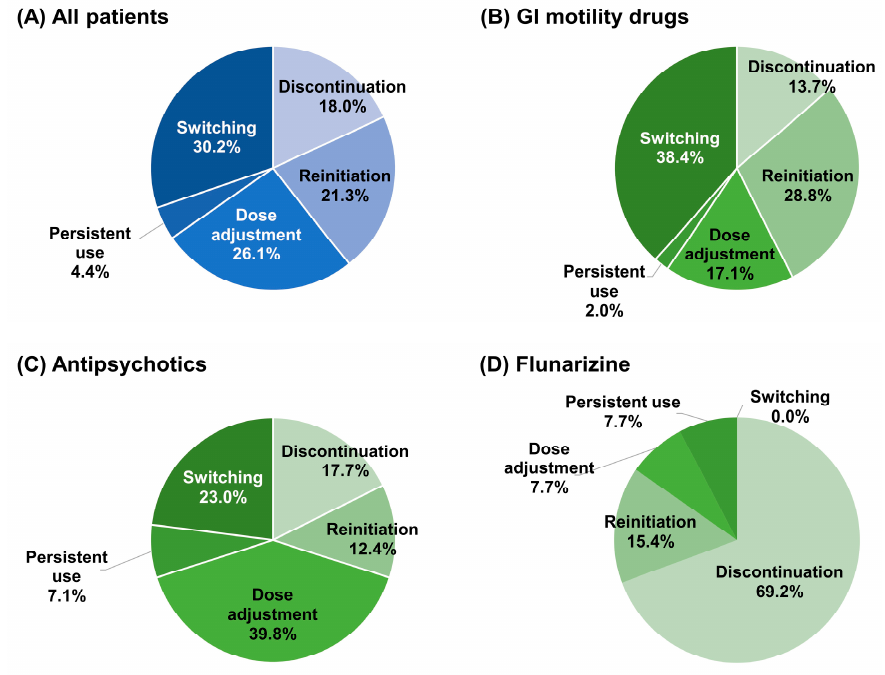
Figure 2. Treatment patterns after the occurrence of incident drug ‐ induced parkinsonism. Abbreviations: GI,